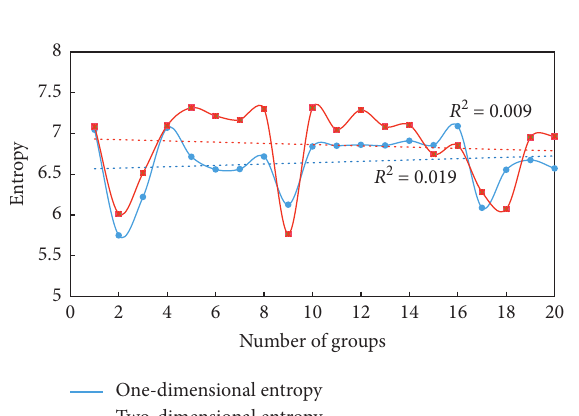
Figure 7: Entropy of slightly dense sand.